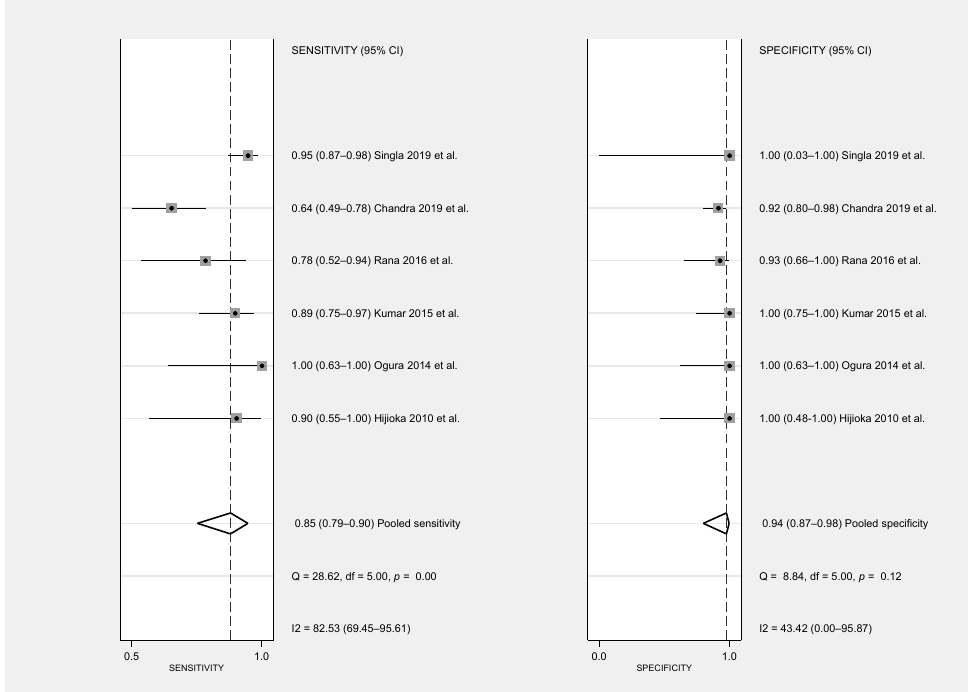
Figure 3. Forest plot showing study-specific [15–19] and pooled sensitivity and specificity with corresponding heterogeneity statistics.